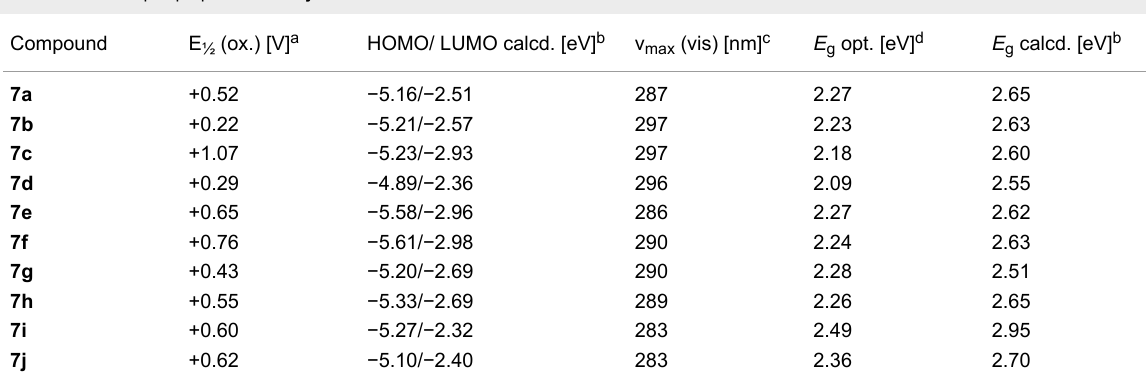
Table 3: Electro-optic properties of 7a–j